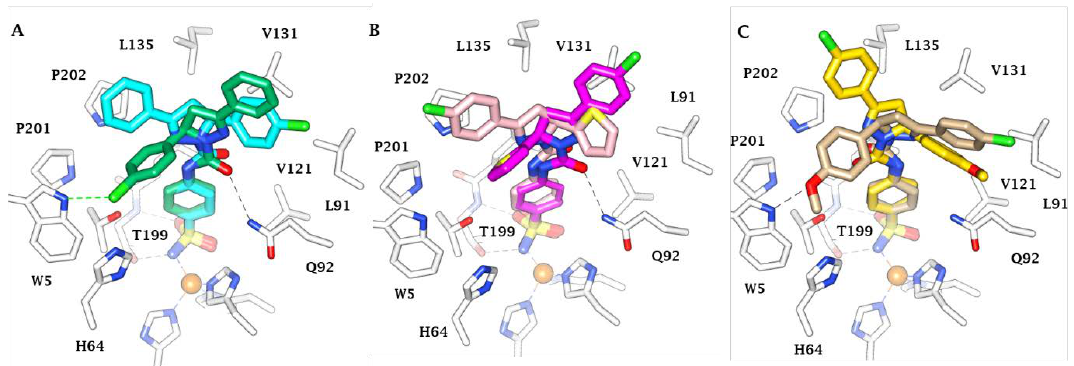
Figure 3. Docked binding orientations of ( A ) (R) -6 (green) and (S) -6 (cyan), ( B ) (R) -18 (magenta) and (S) -18 (pink), and ( C ) (R) -21 (tan) and (S) -21 (gold) to CA IX (pdb 5FL4). H-bonds are represented as dashed lines.